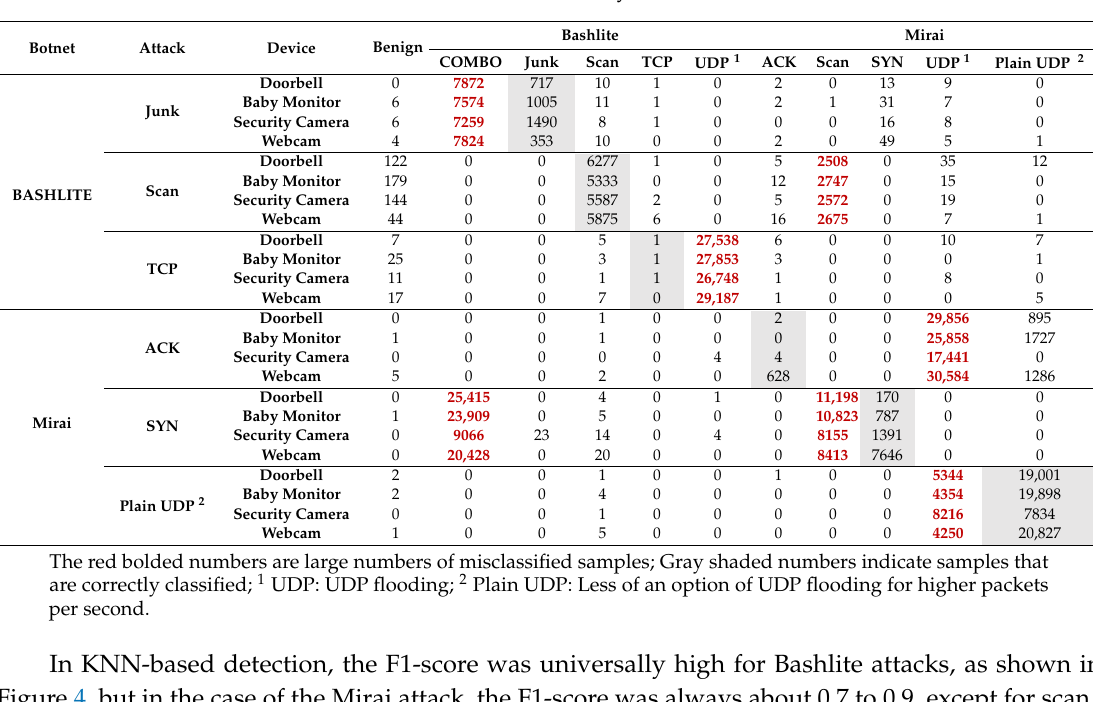
Table 12. Detailed results of the naïve Bayes-based botnet detection.